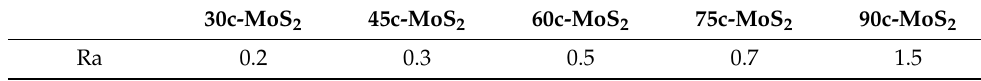
Table 1. Average surface roughness of MoS 2 under different ALD cycles. Figure 2. AFM characterization of surface morphology of ( a ) 30c-MoS 2 nanolayer, ( b ) 45c-MoS 2 nanolayer, ( c ) 60c-MoS 2 nanolayer, ( d ) 75c-MoS 2 nanolayer, and ( e ) 90s-MoS 2 nanolayer.